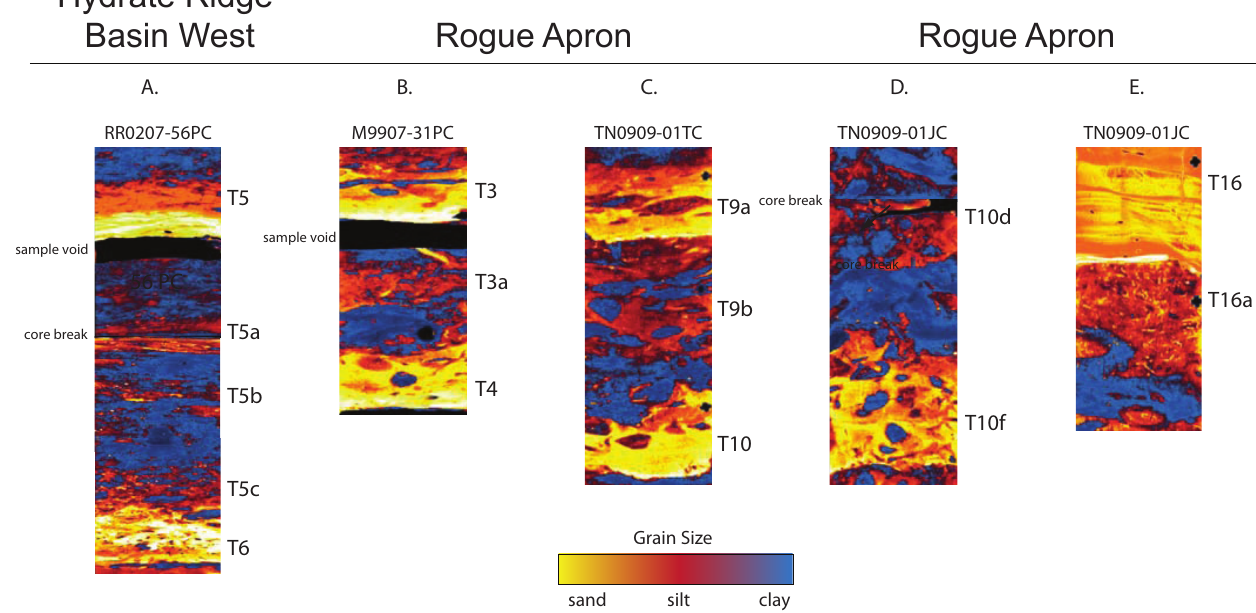
Fig. 4. Enhanced CT imagery shown for representative thin turbidites in at Hydrate Ridge and Rogue Apron. CT imagery shown in context in Fig. 3. CT density imagery processed to show approximate sand and silt (orange and yellow); fine silt (orange) and hemipelagic mud (blue). Approximate grain size key shown at bottom. Some units show typical structure such as cross bedding (T5a, T9a, upper and middle left panels), while others have largely lost primary structure due to bioturbation (T9d, T10d) (modified after Goldfinger et al.,